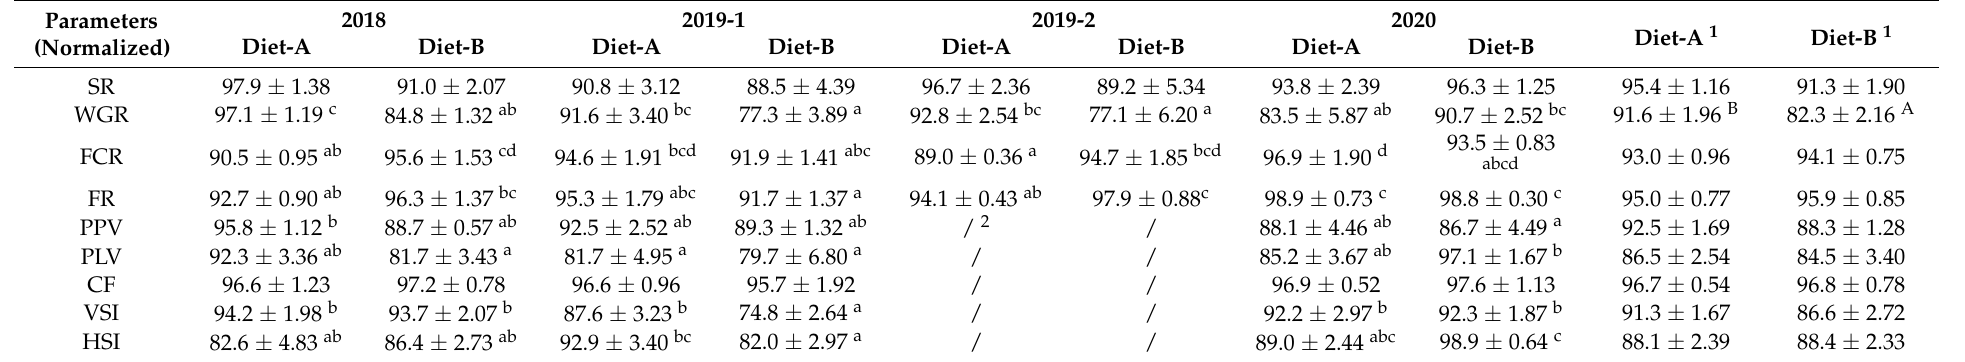
Within the same row, different superscript lowercase letters “ a–d ” denote significant differences among experimental groups based on eight diets (Duncan’s test; p < 0.05); different capital letters “ A ” or “ B ” denote significant differences between the mean of Diet-A and Diet-B ( t -test; p < 0. 05). SEM: Standard error of the mean. 1 The mean of the growth performance of the four growth trials. 2 The symbol “/” means not